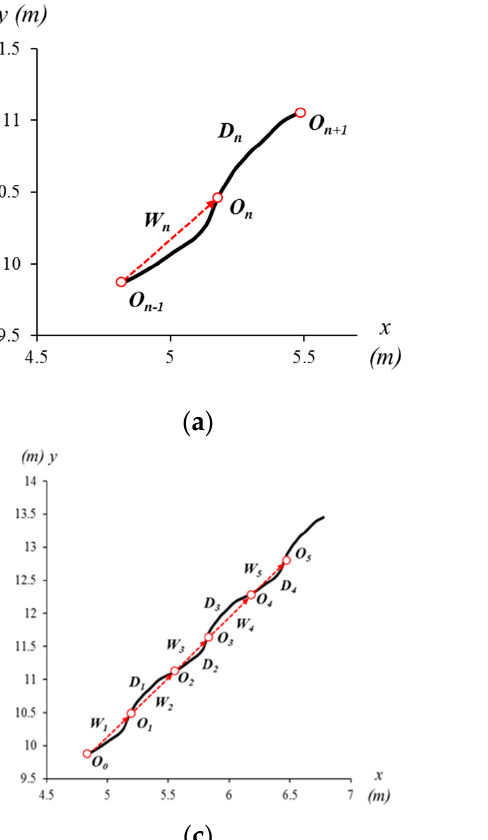
Figure 4. Head trajectories of the participant A (P A ) for a walking vector ( a ) on the x - y coordinate systems and ( b ) on the new x ′ - y ′ coordinate systems, as well as trajectories of six walking vectors of P A ( c ) on the x - y and ( d ) x ′ - y ′ coordinate systems (gait eye diagram at the head type-I, GE-H I). Data in Figure 4d are divided into positive and negative values on the y ′ -axis. When the head is moving toward the left by stepping with the left foot, y ′ -values are positive. When the head is moving toward the right to step with the right foot, y ′ -values are nega- tive. Normally, heel strike (HS) appears in the middle of the nearest two vertical peaks (VPs) which means the middle of the unit trajectory ( D n ). Therefore, it is easily recognized